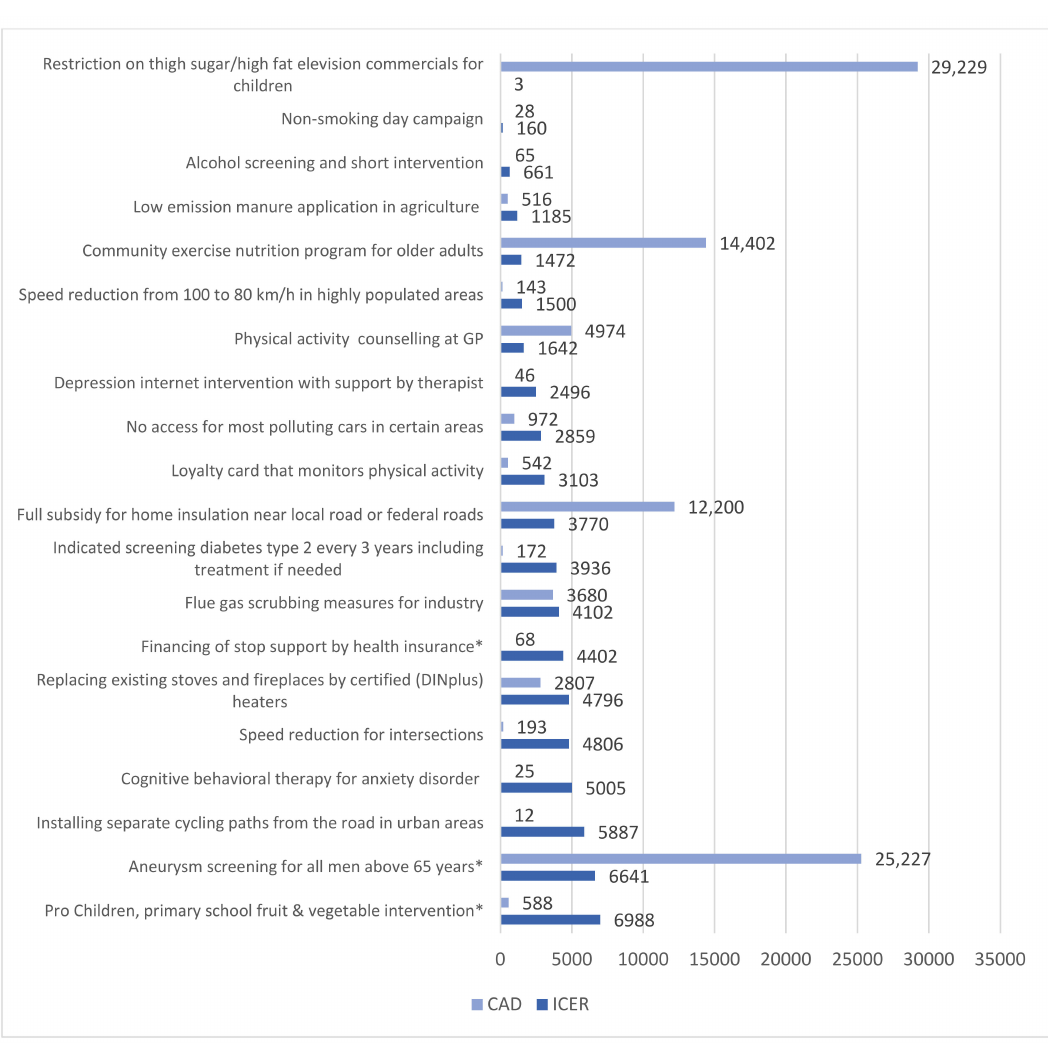
Figure 4. Top 20 ranking most cost-e ff ective interventions (based on ICER € 2015), with Conservative Averted DALYs